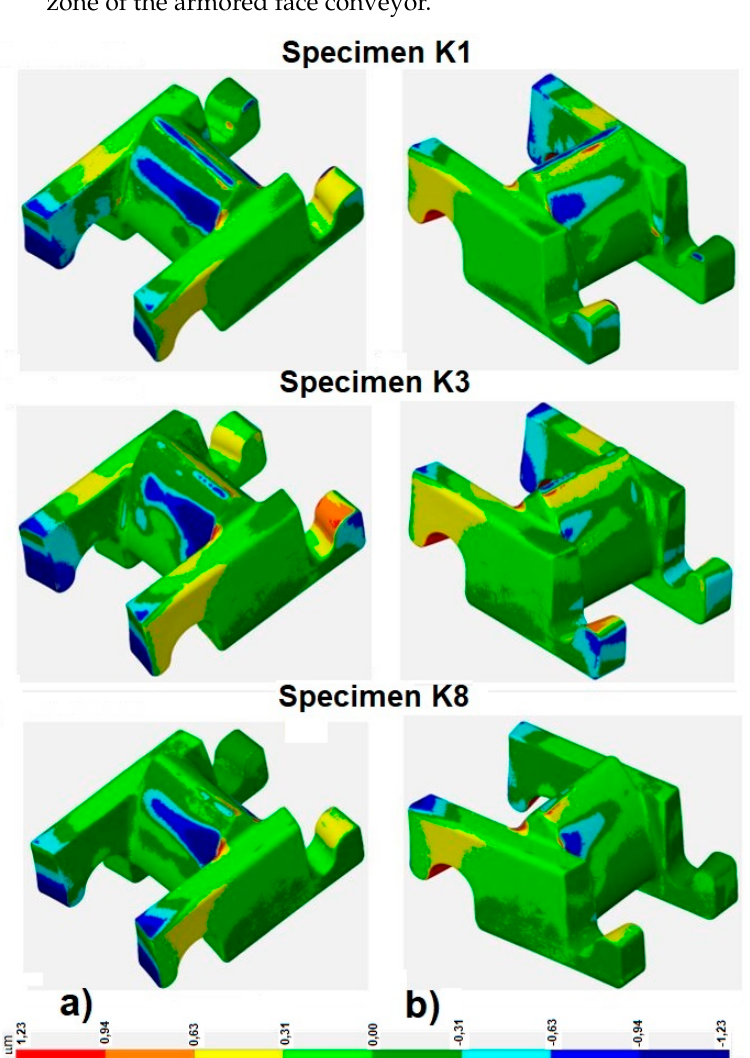
Figure 15. Measurements results of changes deviation of surfaces for selected segments, a comparison of scans of toothed segments models made before tests and after tests: ( a ) at loading caused by the shearer braking force, ( b ) at loading caused only by the shear pass.